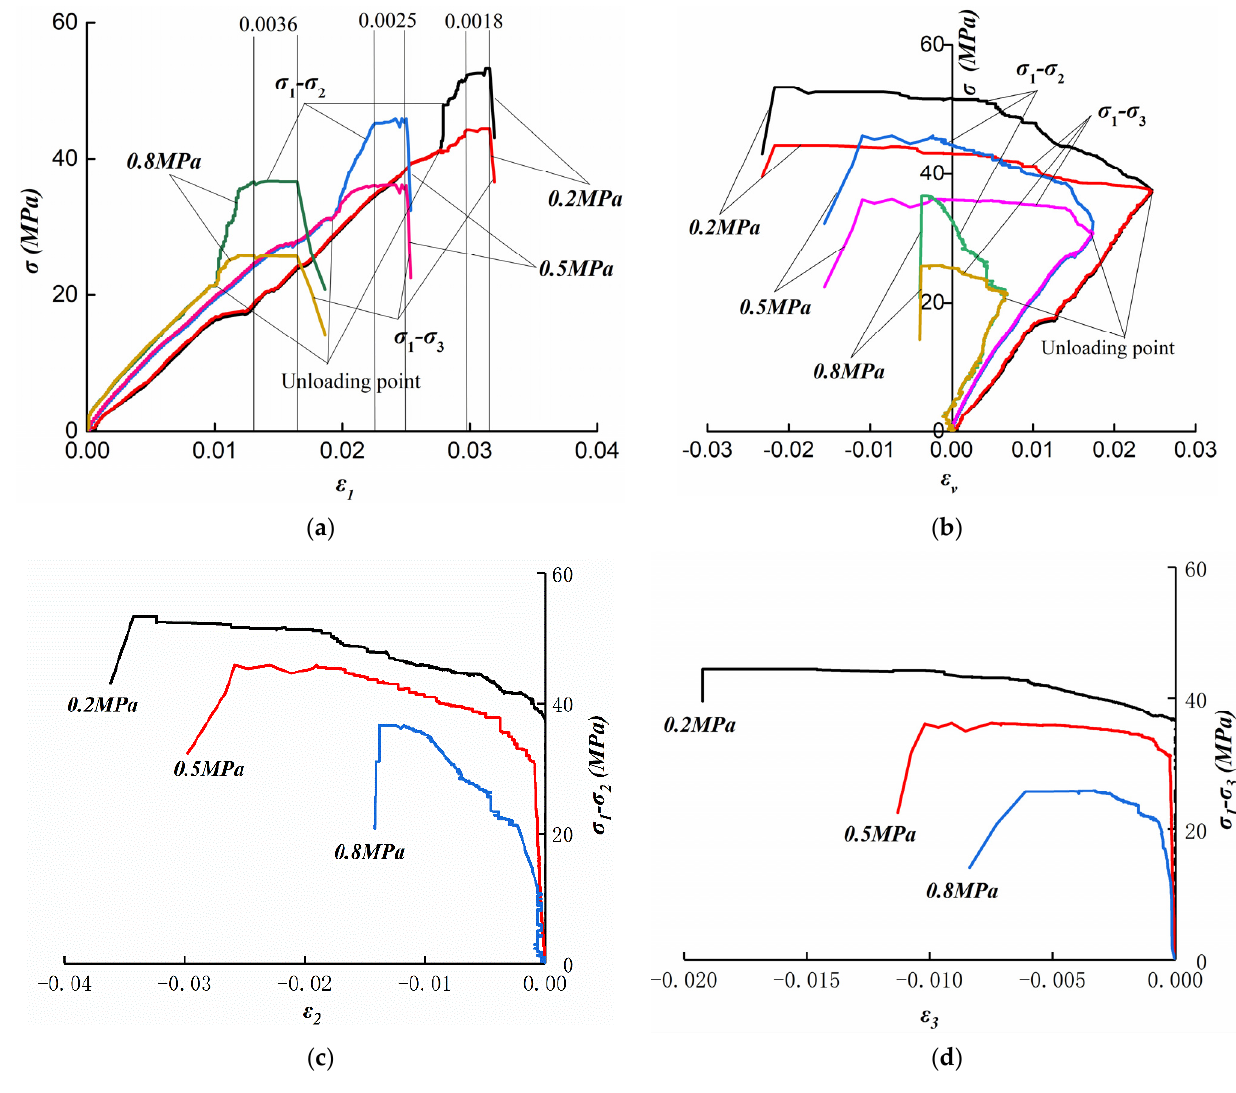
Figure 5. Stress–strain curves for the unloading test. ( a ) ε 1 − ( σ 1 − σ 2 ) and ( σ 1 − σ 3 ) curves; ( b ) ε v − ( σ 1 − σ 2 ) and ( σ 1 − σ 3 ) curves; ( c ) ε 2 − ( σ 1 − σ 2 ) curves; ( d ) ε 3 − ( σ 1 − σ 3 ) curves.